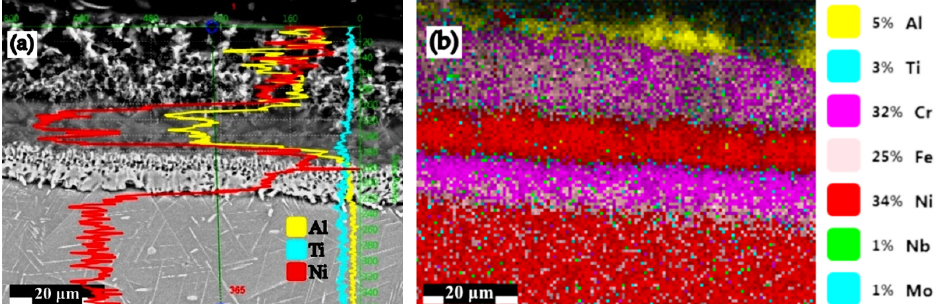
Figure 7. Aluminized Inconel 718 superalloy at 900 °C for 5 h, in a pack aluminizing mixture (98 wt.% FeAl40 + 2 wt.% NH 4 Cl) ( a ); %Al/%Ni weight proportion ratio variation in the investigated zones ( b ); SEM-EDS spectra corresponding to the different zones investigated ( c – e ).